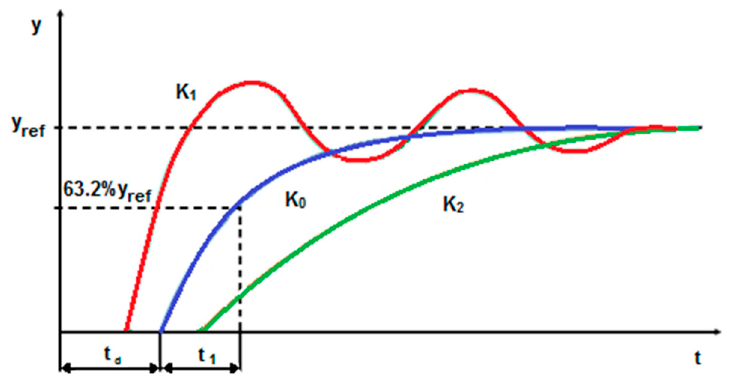
Figure 1. Dynamic characteristics of a properly designed control system (gain value K 0 ), and of systems with degraded control quality (gain values K 1 > K 0 or K 2 < K 0 ).